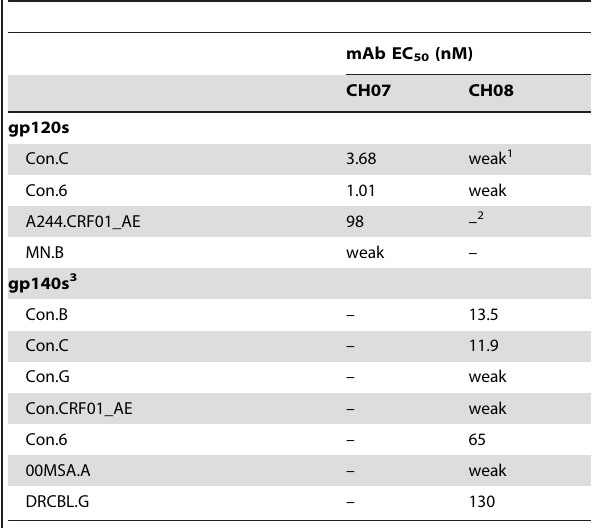
Table 1. Relative binding affinity of mAbs CH07 and CH08 to Env proteins.